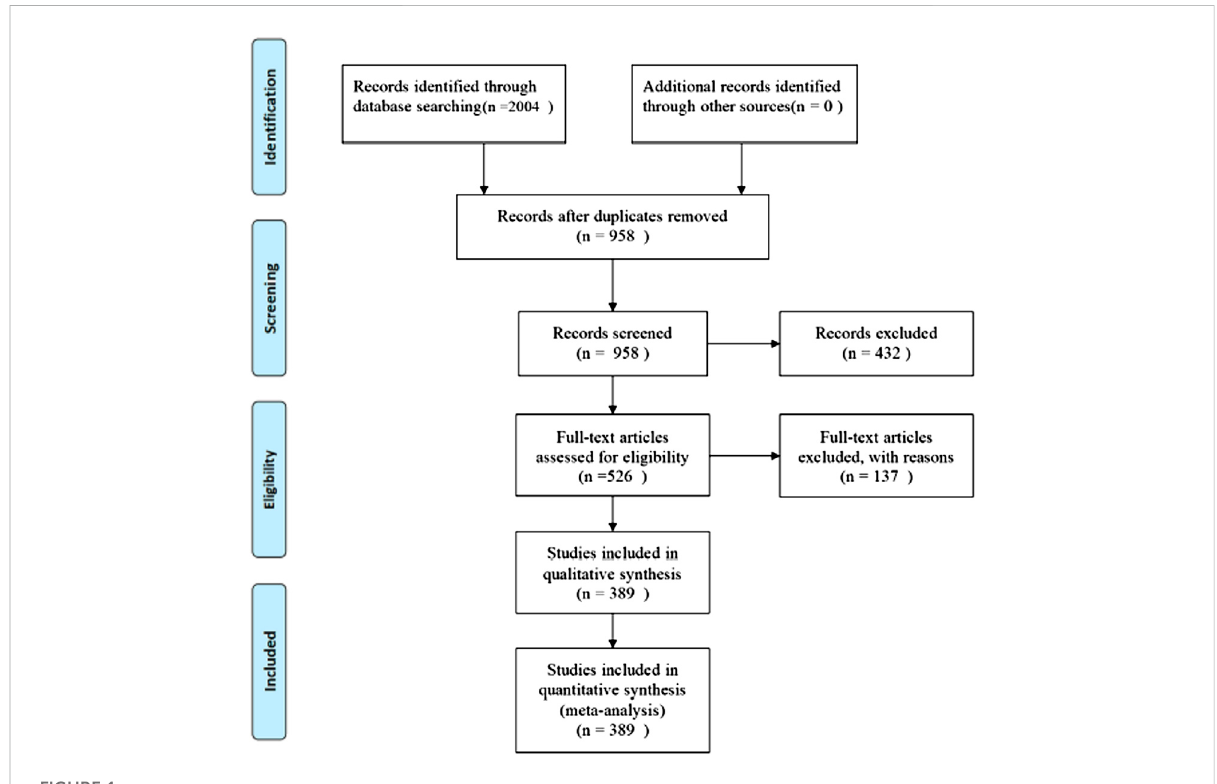
FIGURE 1 PRISMA fl ow